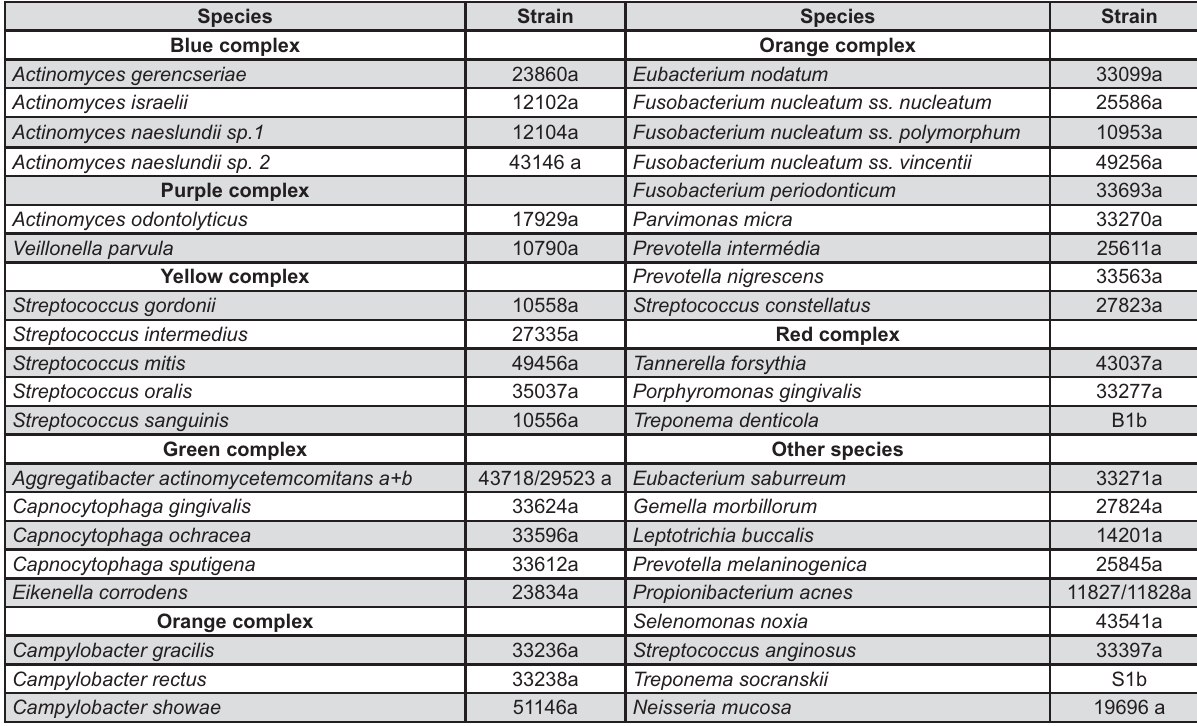
Figure 1- Bacterial strains employed for the development of the DNA probes a- ATCC (American Type Collection, Rockville, MD); b- Forsyth Institute, Boston,